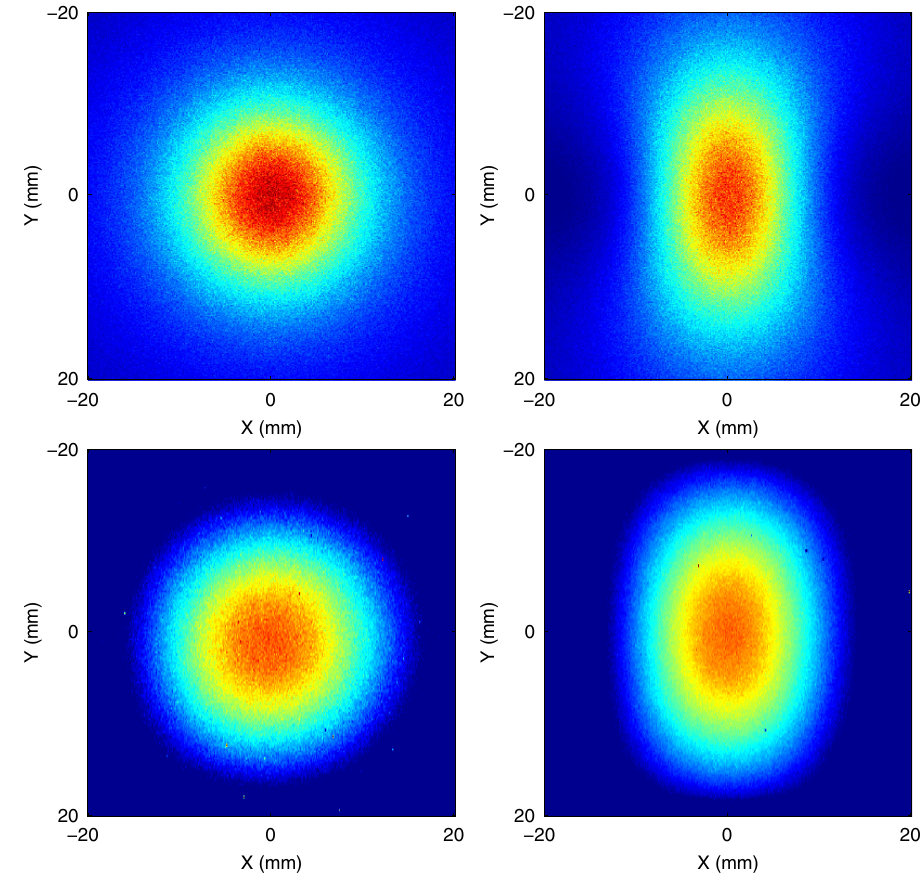
FIG. 13. Spatial distributions of Compton gamma-ray beams for different polarizations of the incoming laser beams. The gamma-ray beams are produced by Compton scattering of a 680 MeV electron beam and a 378 nm laser beam. The observation plane is about 27 meters downstream from the collision point. The upper plots are the simulated images using the MCCMPT code. The lower ones are the measured images. The left images are produced using a circularly polarized laser beam; the right images with the linearly polarized laser